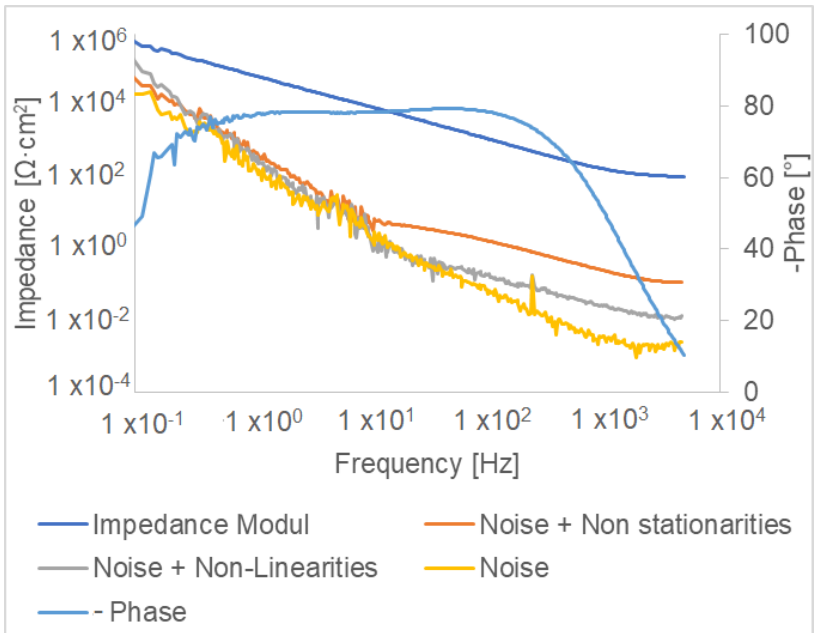
Figure 9. Example of ORP-EIS measurement. TSA 14 V 55°C after one hour of immersion in acidic solution.